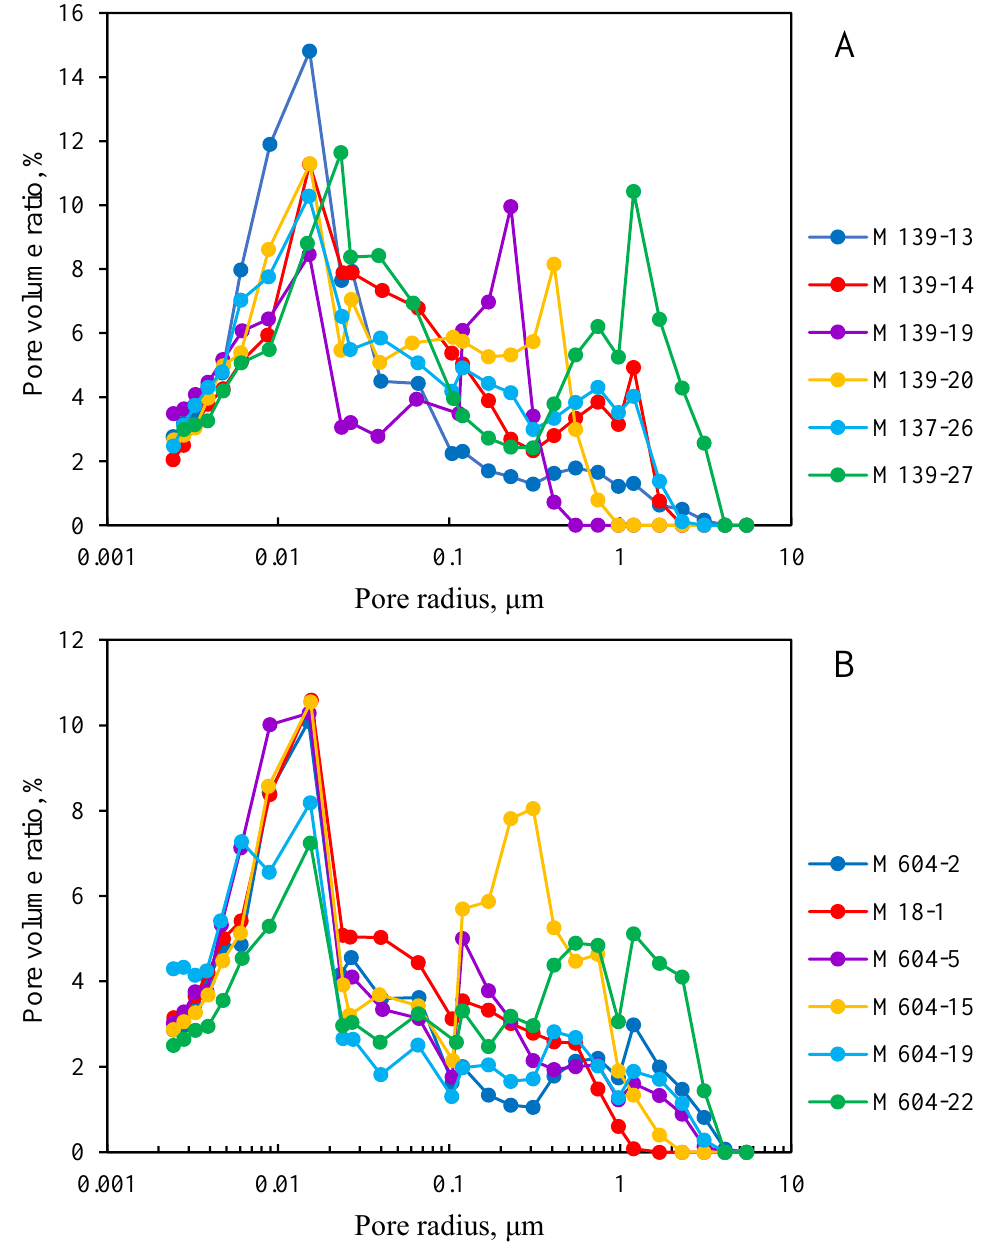
Figure 6. Pore throat distribution obtained through high-pressure mercury injection experiments on core samples from blocks Ma131 and Ma18: ( A ) Block Ma131, well M139; and ( B ) Block Ma18, wells M18 and M604.